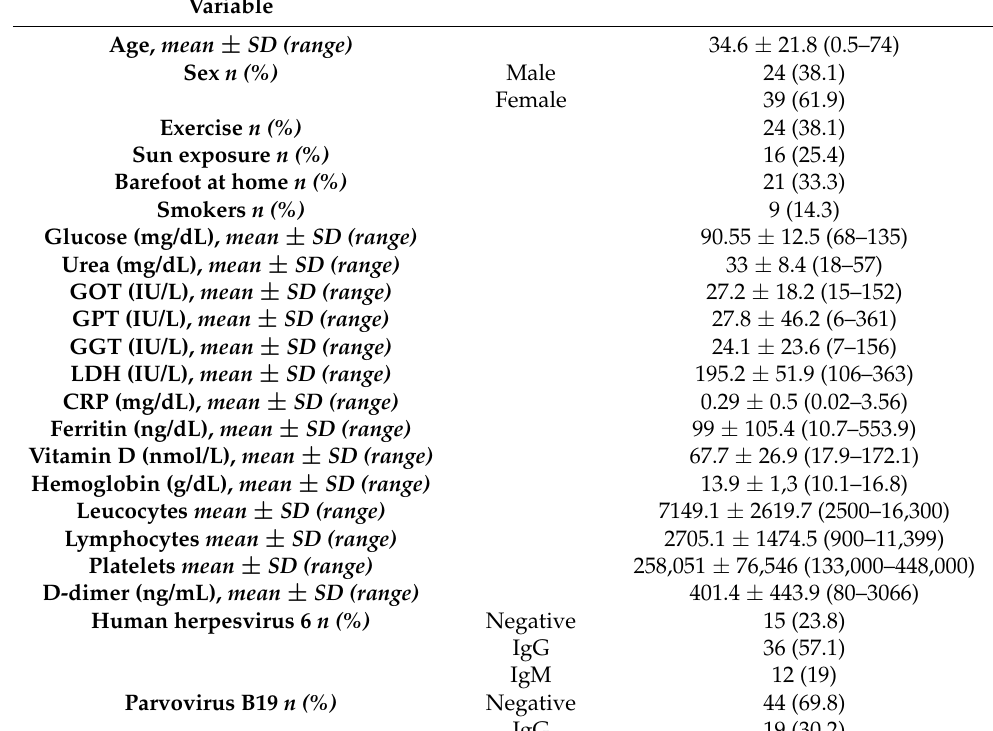
Table 1. Epidemiological, analytical, and microbiological characteristics of patients with COVID-19- associated cutaneous